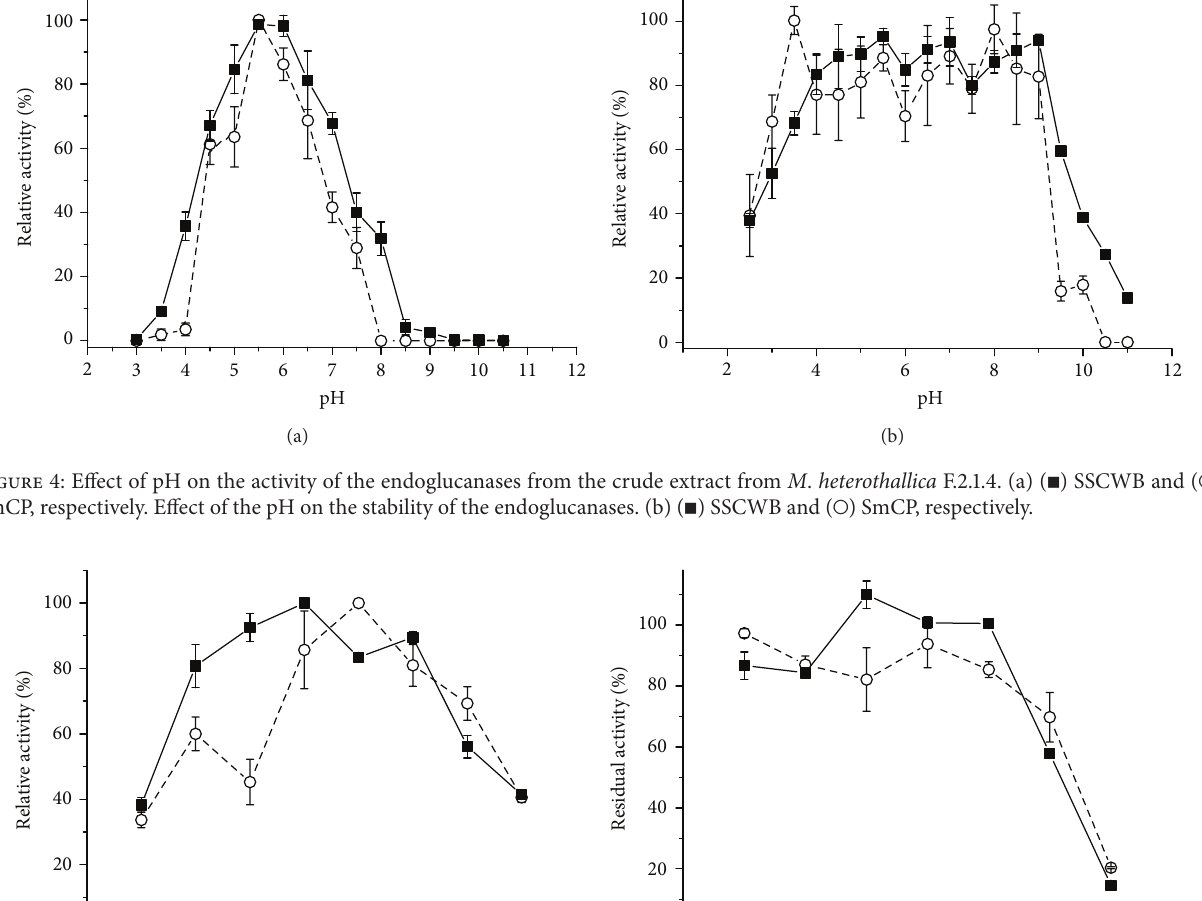
opposite effects or different degrees of